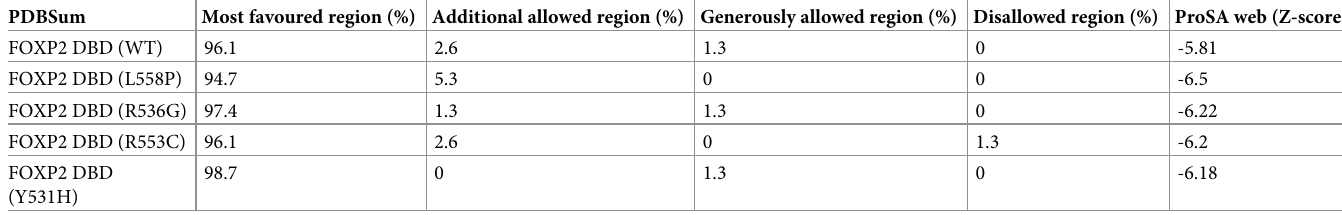
Table 6. The results of three-dimensional model